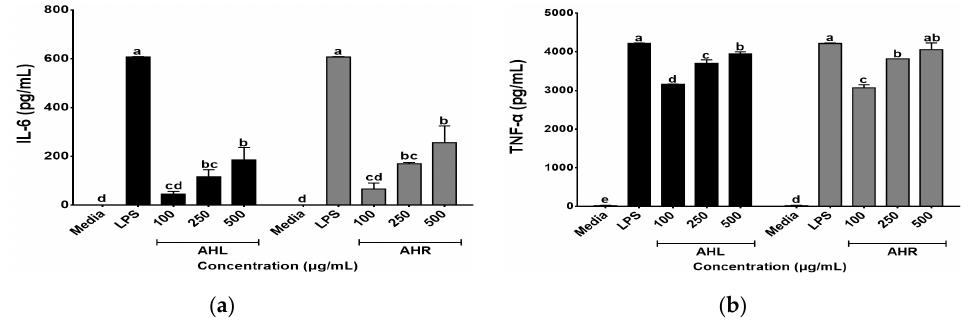
Figure 5. Effects of A. hookeri leaves (AHL) and A. hookeri roots (AHR) extracts on the productions of ( a ) IL-6 and ( b ) TNF- α by RAW 264.7 cells. The data was expressed as the mean ± SEM. a–e Different letters are significantly different at p < 0.05. Table 2. Effects of A. hookeri leaves (AHL) and A. hookeri roots (AHR) extracts on the body and organ weights of C57BL/6 mice immunosuppressed by